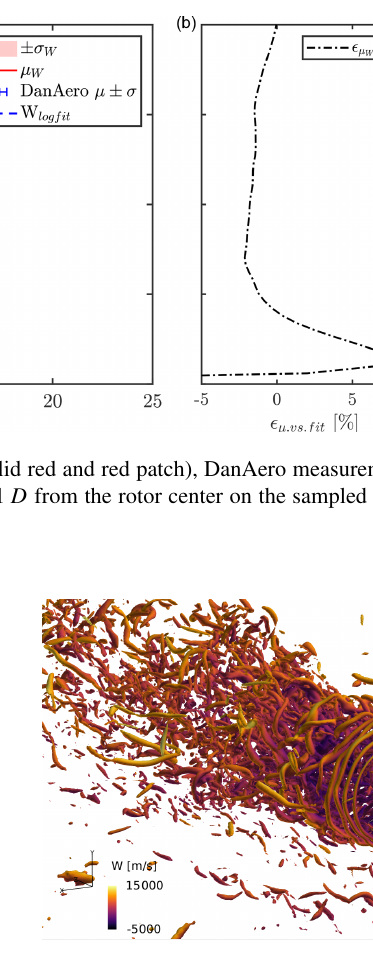
Figure 9. Isobars of Q criterion = 0.4 colored with value of flow velocity W , ranging from − 5 . 0 to 15.0ms − 1